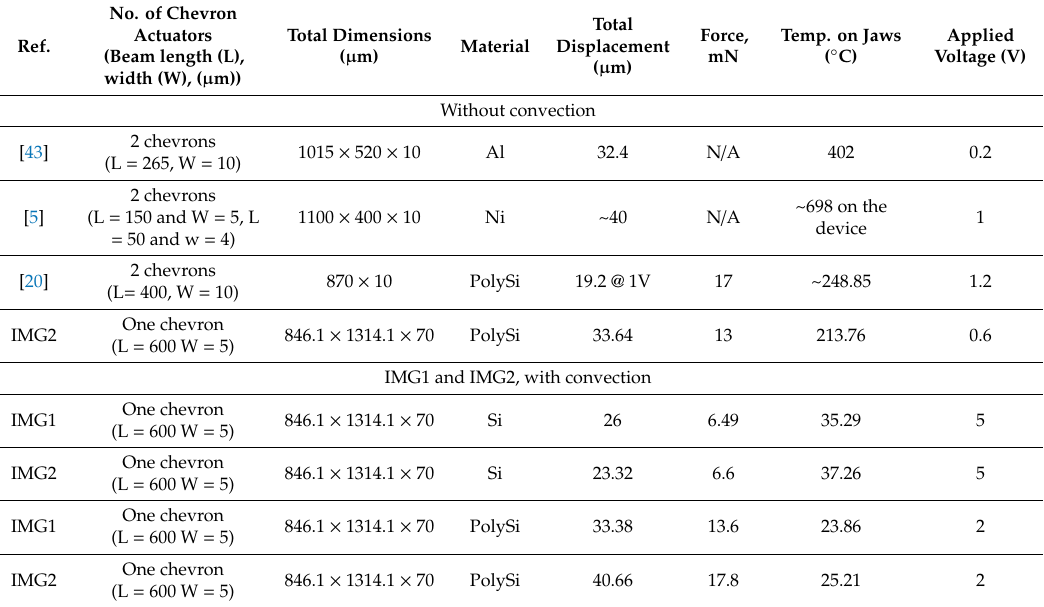
Table 8. Comparison with other electrothermal